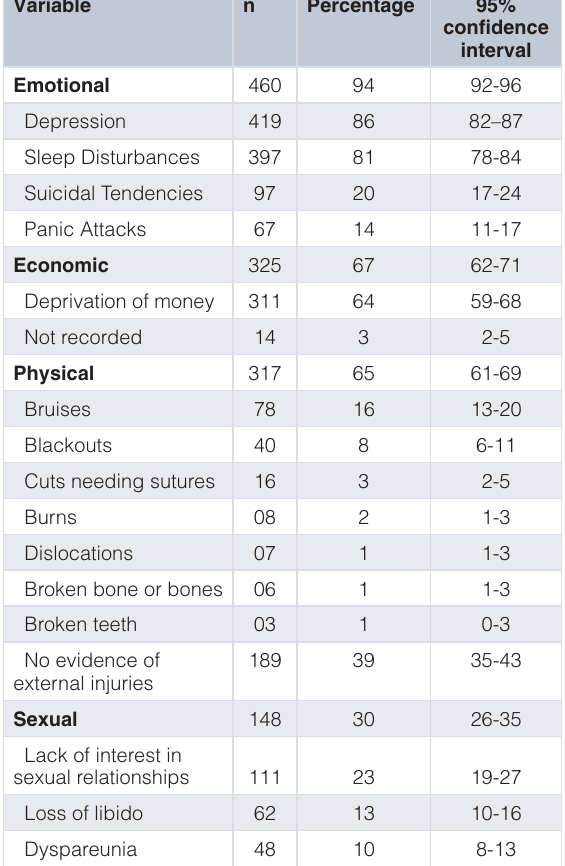
(Table 9). Out of a possible total of five, 19% of women had a score of ≥ 3 indicating a significant risk of repeat violence in the future (Table 10).